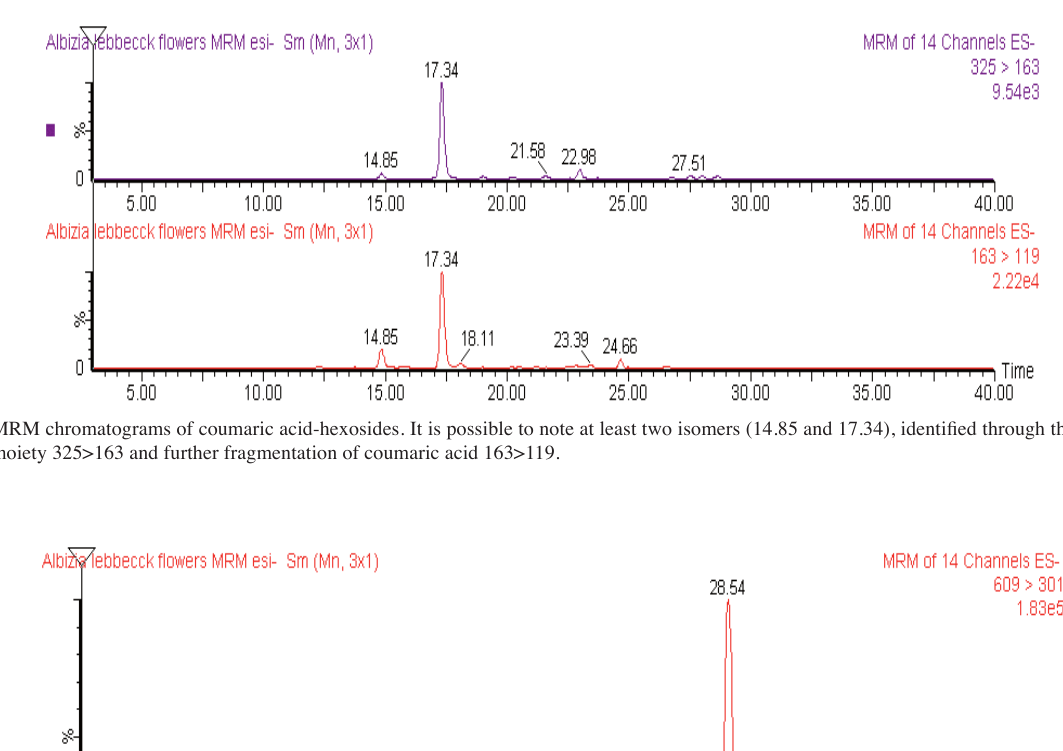
(RDA) cleavage and loss of a water molecule (m/z 425 and